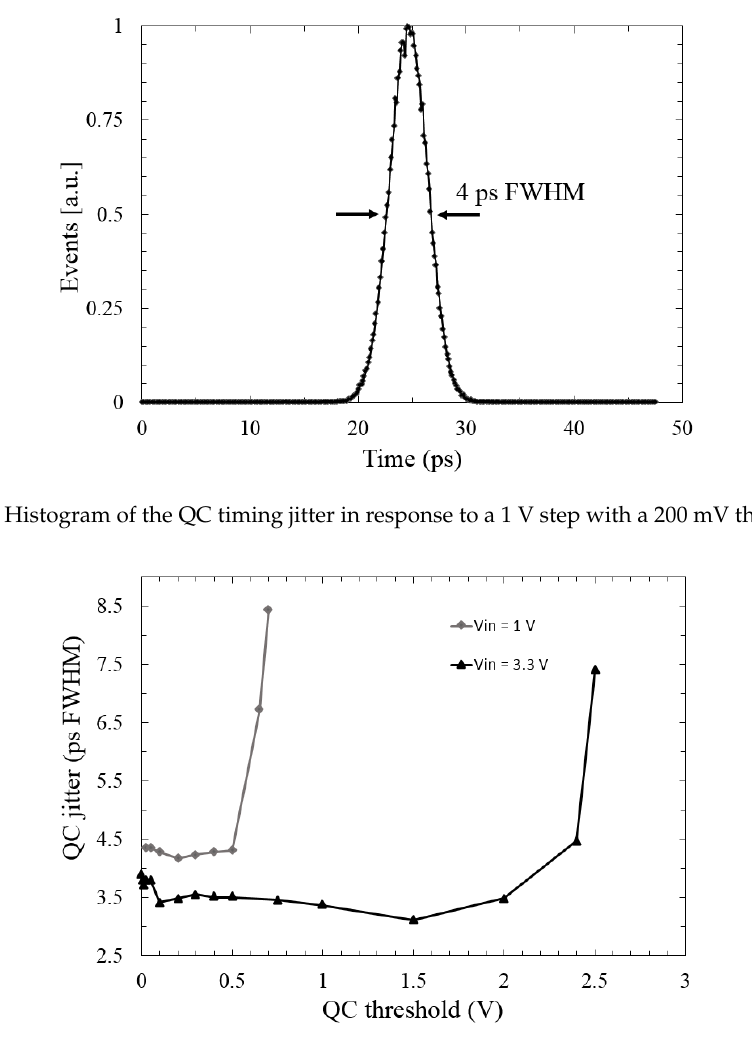
botg Figure 9. QC timing jitter as a function of the threshold.